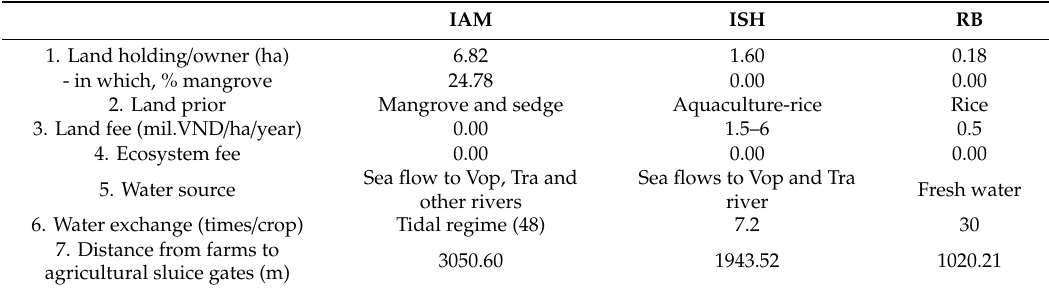
Table 2. Land area and its